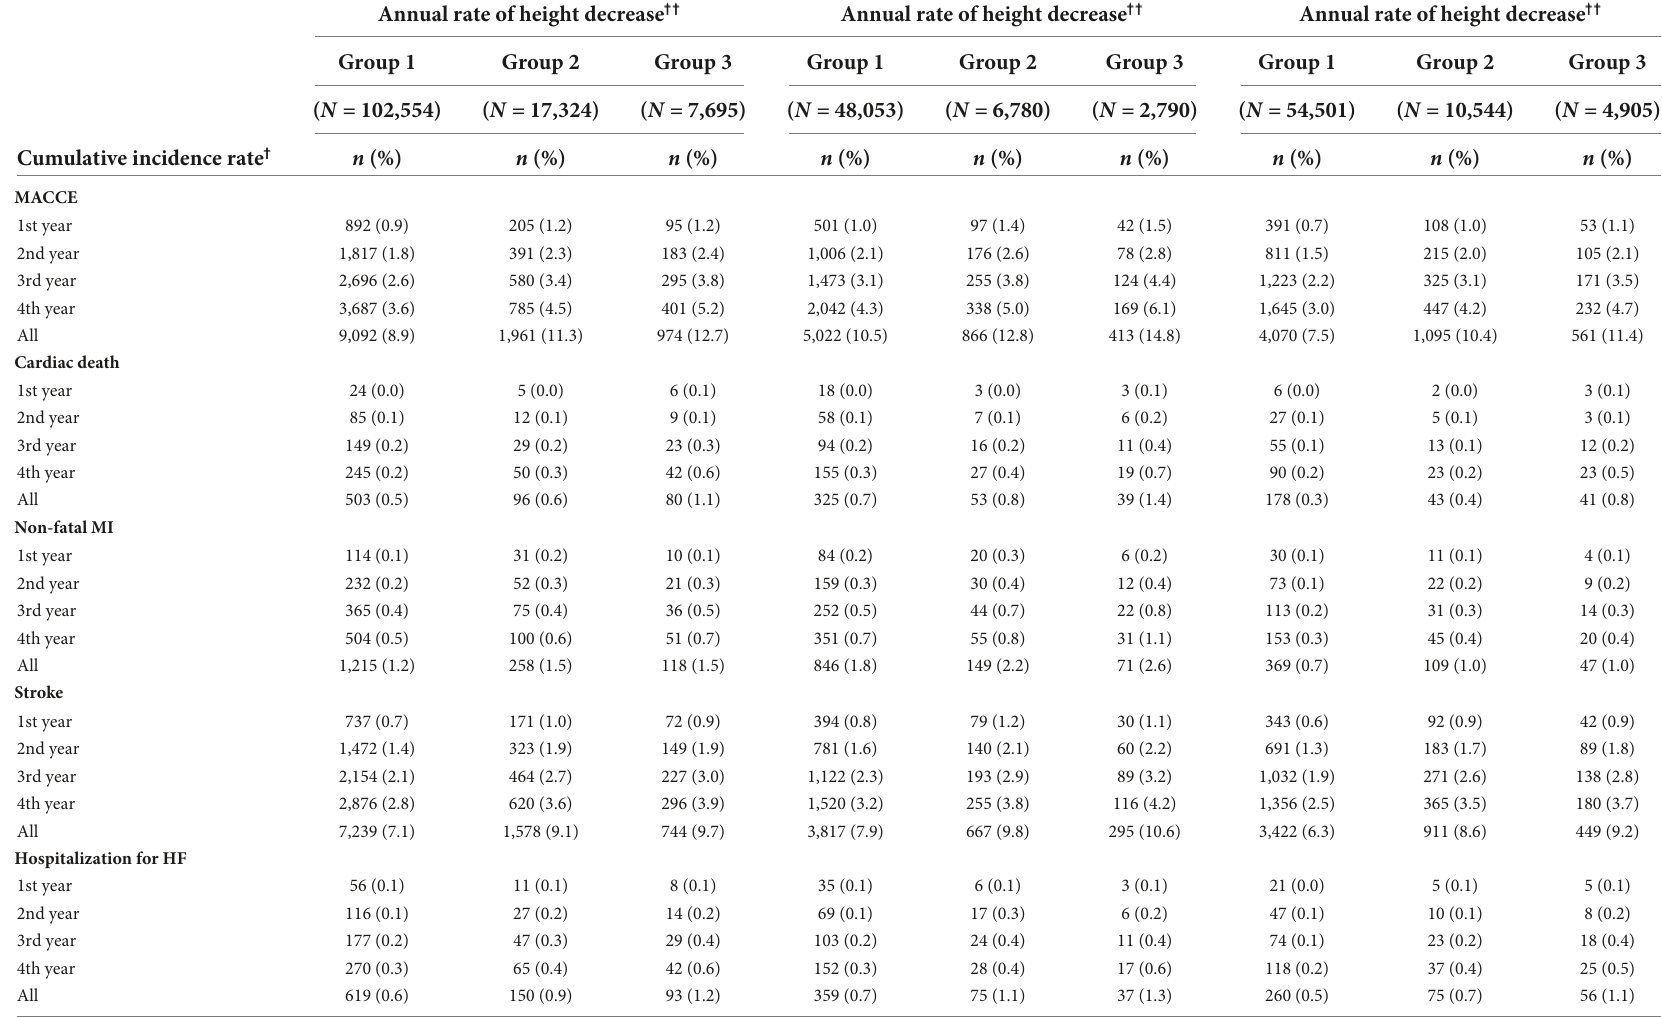
TABLE 2 The cumulative adverse cardiovascular and cerebral event incidence rates per the annual height decrease rate.